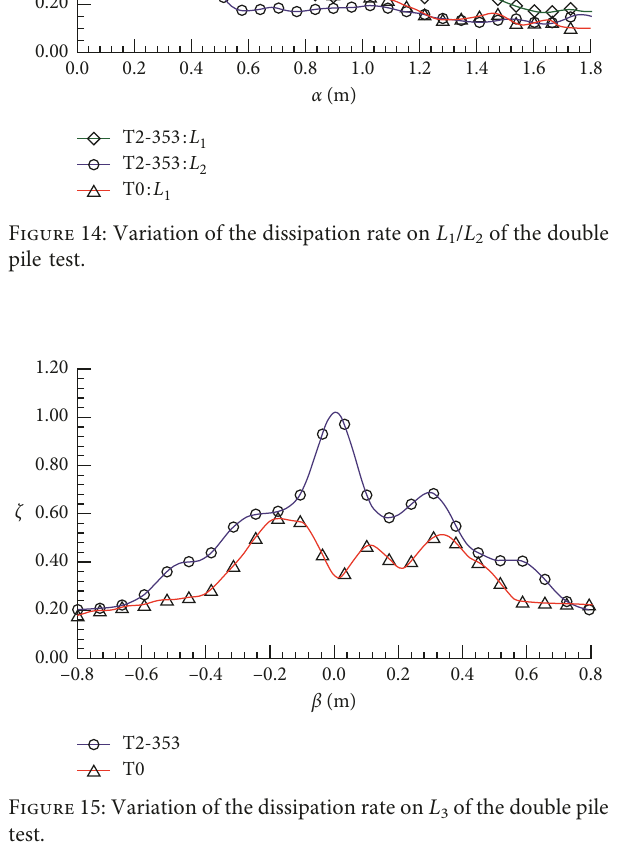
3 of the double pile